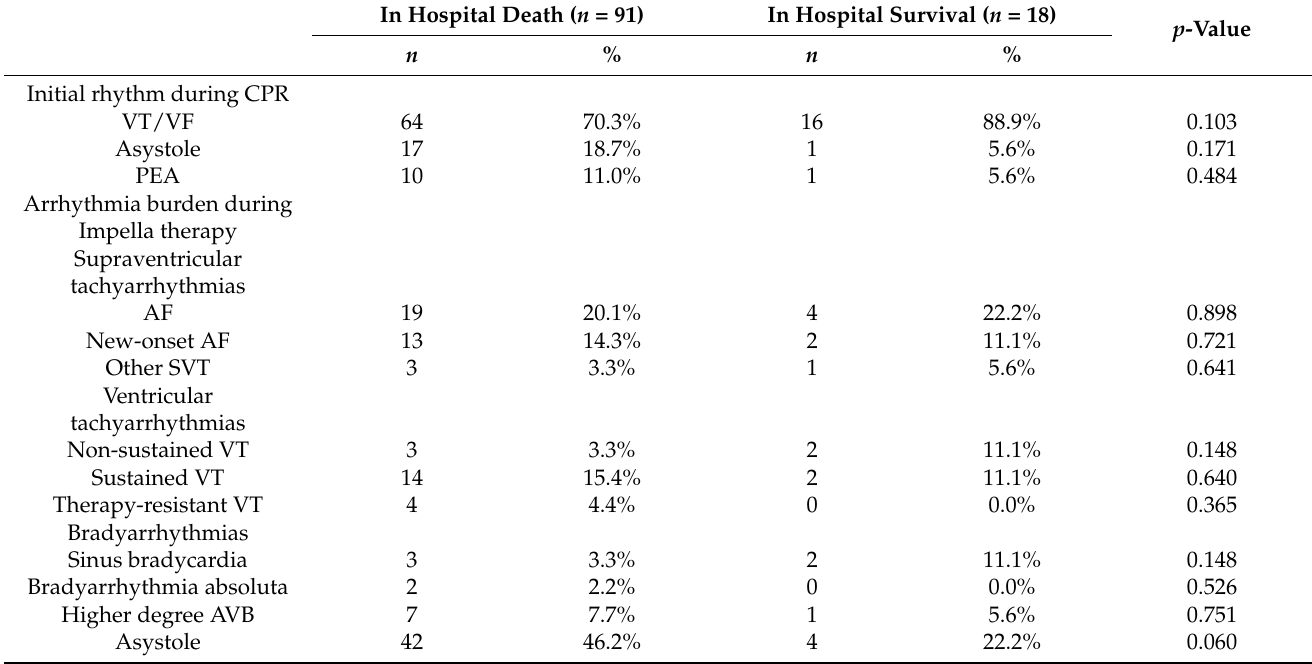
Table 3. Arrhythmia burden during Impella therapy in hospital survivals vs. hospital death.